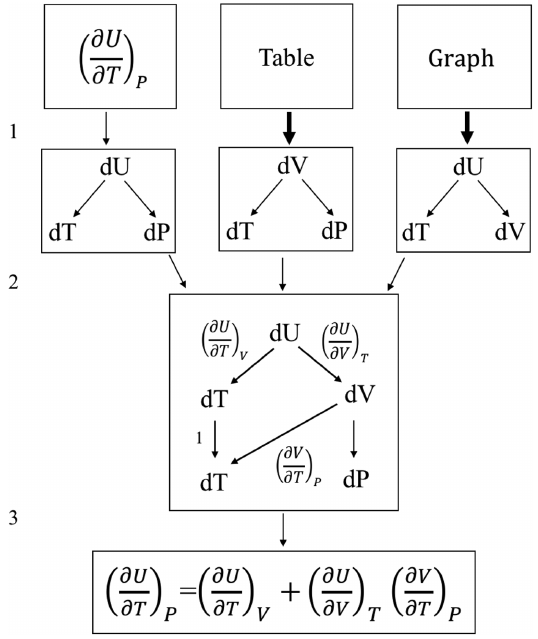
FIG. 9. An AD strategy — the tree diagram submethod.